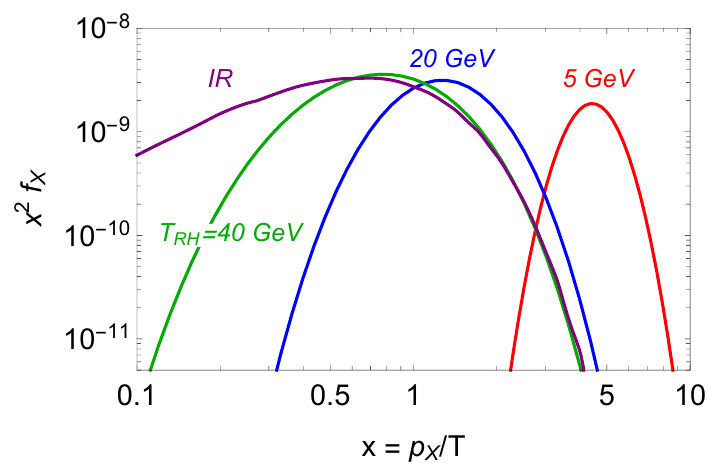
Figure 8 . Dark matter phase space distribution as a function of the DM momentum ( x = p X /T ) for a DM candidate with mass m X = 1 GeV produced from SM Higgs decays, for T RH = 5 , 20 , 40 GeV. The normalization of each distribution is set by choosing the coupling y hXX that gives the correct relic abundance at the various T RH values. The curve labelled “IR” (adapted from ref. [17]) represents the standard IR freeze-in scenario with T RH (cid:29) M med , where most of the DM population is produced at T ≈ M med